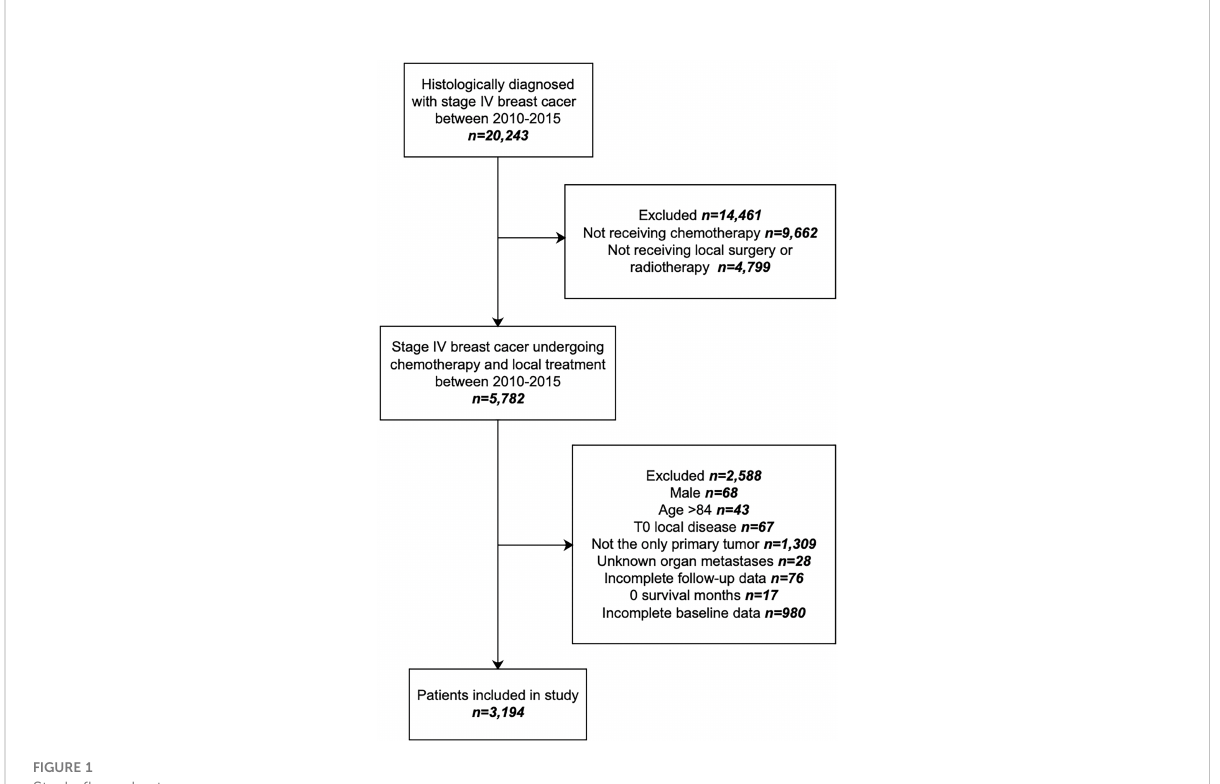
FIGURE 1 Study fl ow